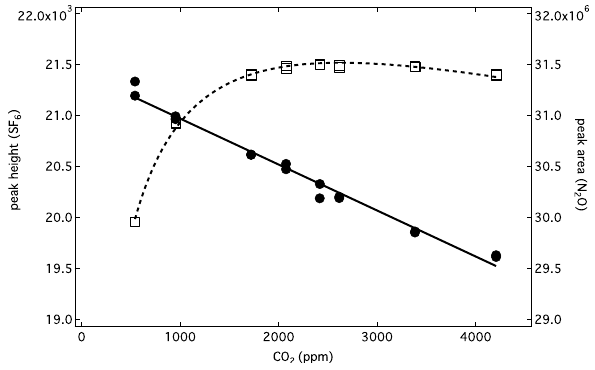
Figure 3: Effect of CO 2 on SF 6 (left axis, closed circles) and N 2 O (right axis, open squares) 533 Fig. 3. Effect of CO 2 on SF 6 (left axis, closed circles) and N 2 O response (arbitrary units). 534 (right axis, open squares) response (arbitrary units).